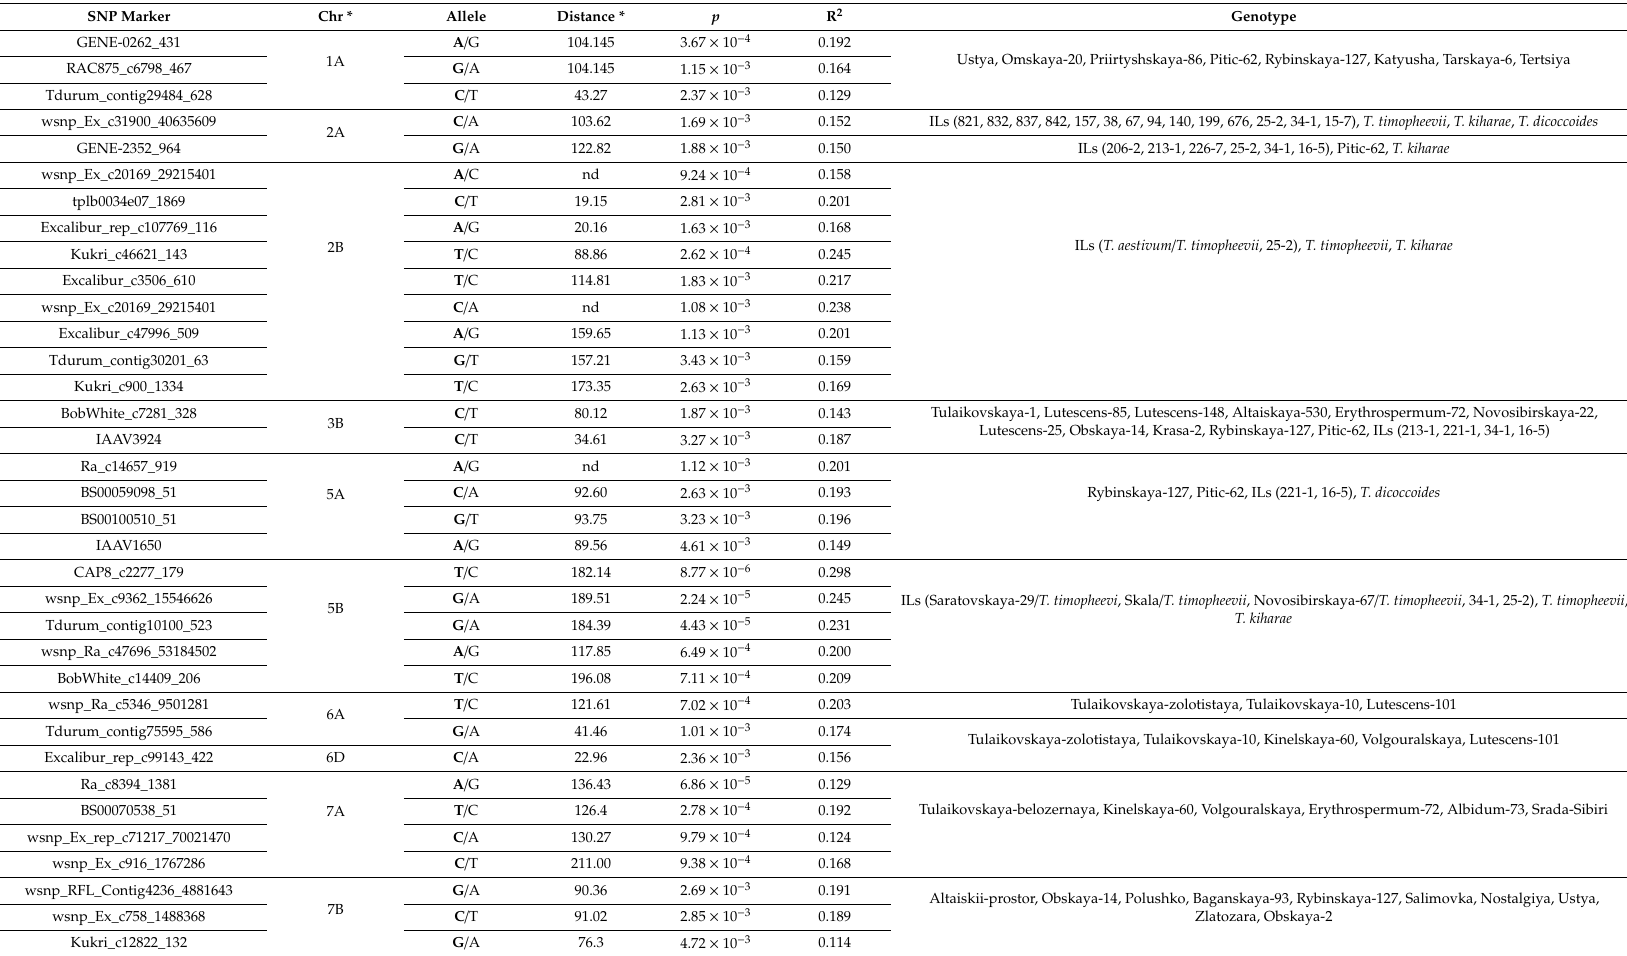
Table 2. Marker-trait associations for stem rust resistance in spring bread wheat